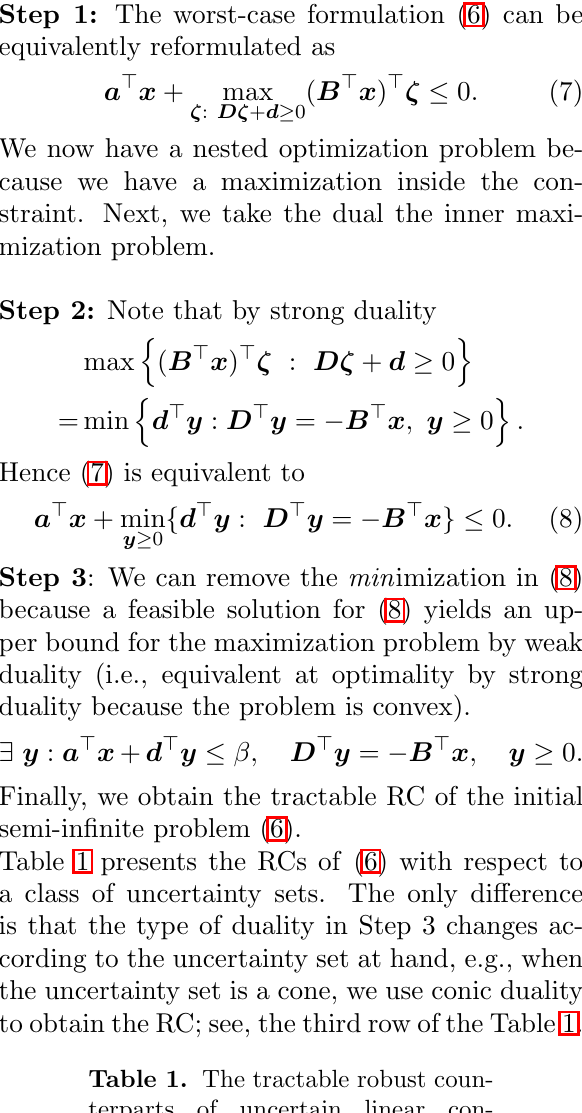
terparts of uncertain linear con-